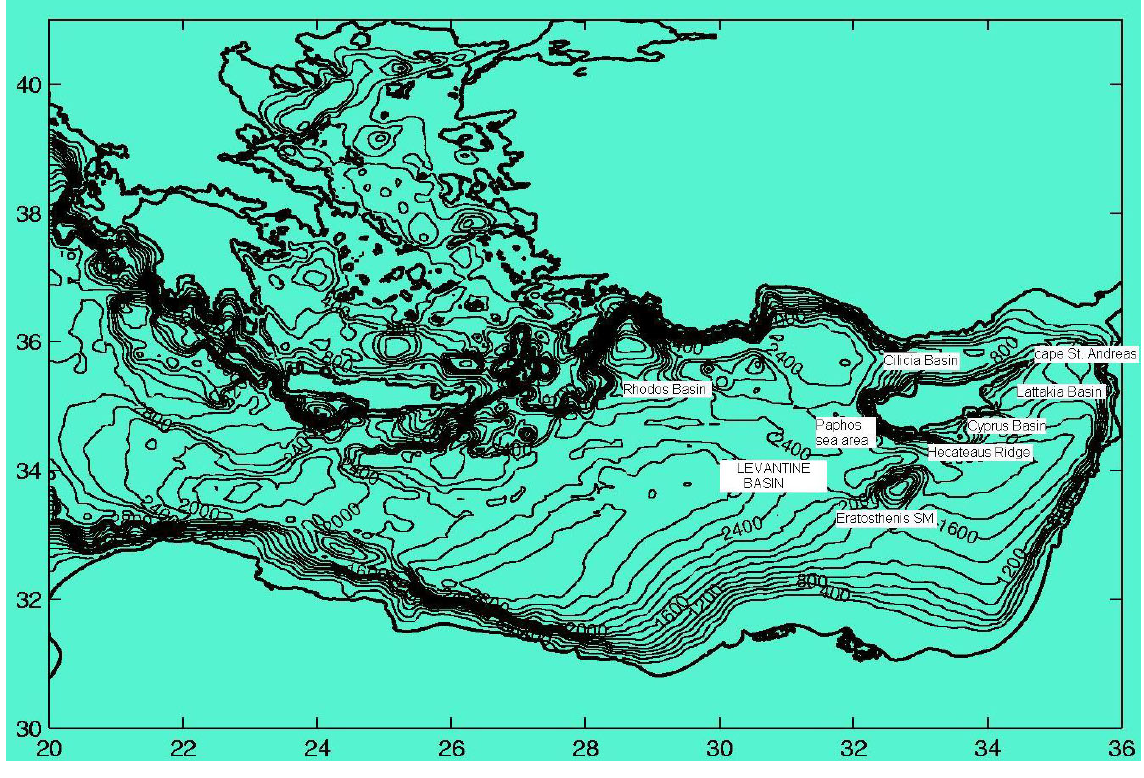
Fig. 3. Physiography and bathymetry of the eastern Mediterranean Sea. In the Levantine Basin some geographical names relevant to the nested CYCOM model for the Cyprus and NE Levantine basins are also